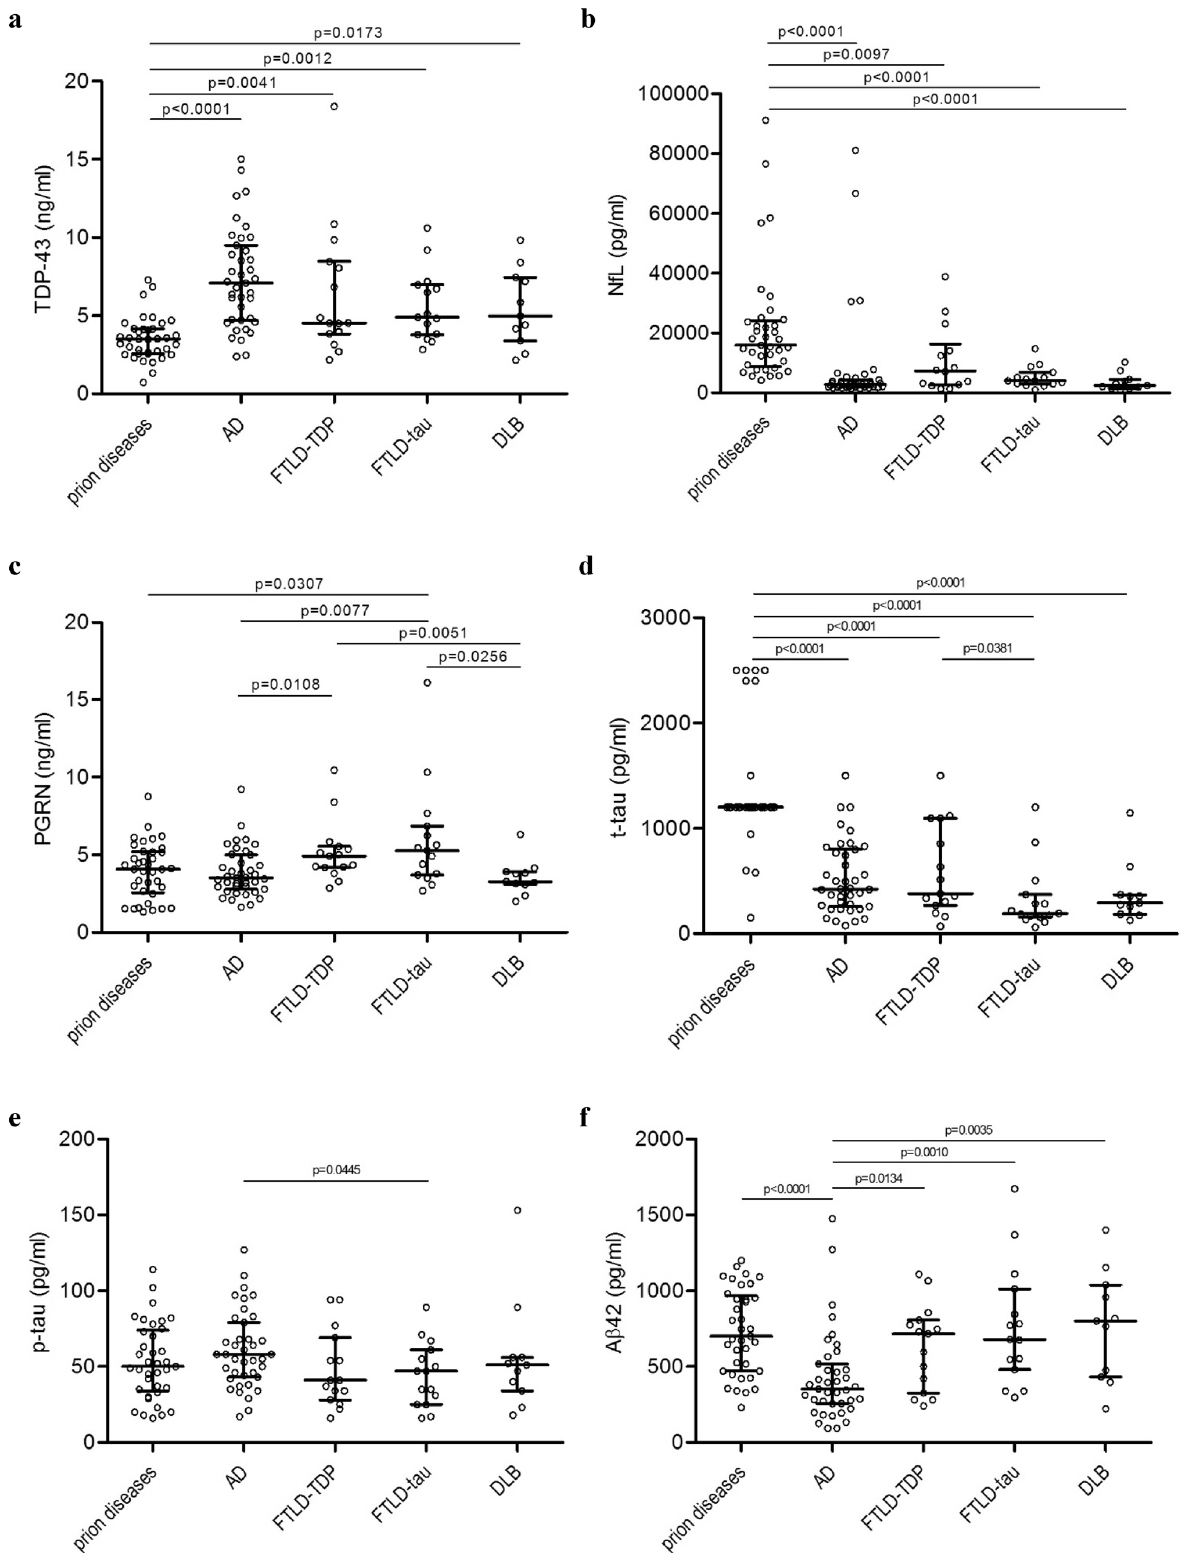
Figure 1. Scatter dot plots represent values of ( a ) TDP-43, ( b ) NfL, ( c ) PGRN, ( d ) t-tau, ( e ) p-tau, and ( f ) Aβ42 individually for prion diseases, AD, FTLD-TDP, FTLD-tau, and DLB. Bars represent medians with the interquartile range. Statistically significant p-values represent the exact two-tailed p-values of the Mann–Whitney test (p < 0.05). TDP-43, TAR DNA binding protein-43; PGRN, progranulin; NfL, neurofilament light chain; t-tau, total-tau; p-tau, phosphorylated-tau (181P); Aβ42, amyloid-beta (1–42); AD, Alzheimer disease; FTLD-TDP, frontotemporal lobar degeneration with TDP-43 inclusions; FTLD-tau, frontotemporal lobar degeneration with tau inclusions; DLB, dementia with Lewy